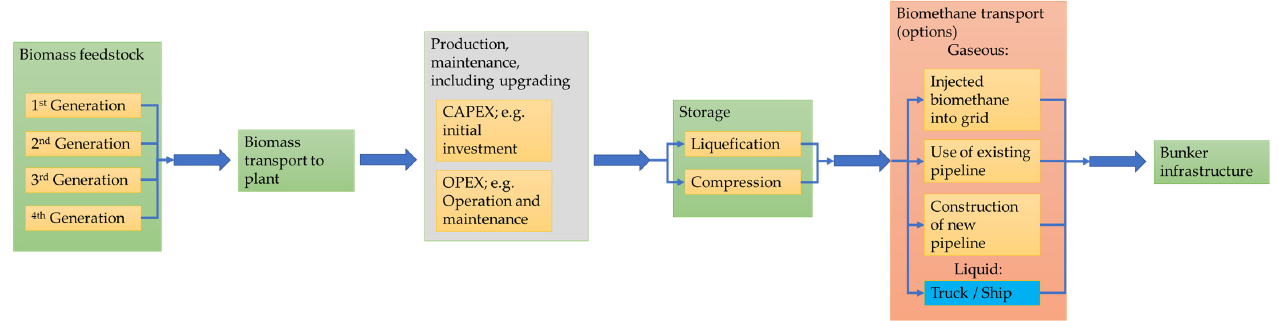
Figure 7. Cost constituents of biomethane from source to vessel and port.